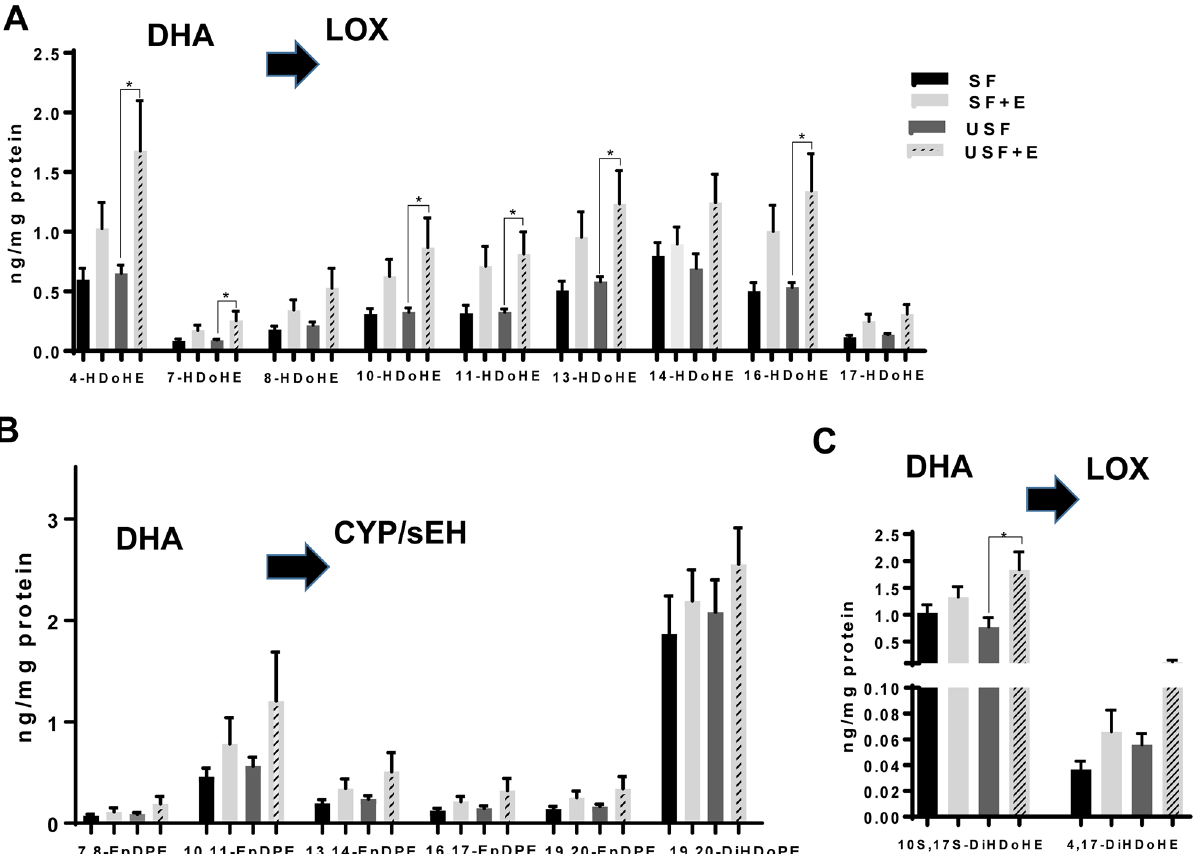
Fig 8. Changes in hepatic oxylipins derived from DHA. A: Levels of DHA-derived hydroxyl-metabolites of LOX pathway. D: Changes in epoxy- and dihydroxy-metabolites of DHA produced via CYP/sEH pathway. C: Pro-resolving DHA metabolites of LOX pathway. Data are presented as the mean ± SEM, Two way ANOVA, (cid:3) P < 0.05, n = 6 animals per group. CYP, cytochrome-P450 epoxygenase; DHA, docosahexaenoic acid; E, ethanol; LOX, lipoxygenase; SF, saturated fat; sEH, soluble epoxide hydrolase; USF, unsaturated fat. See oxylipin abbreviations in S6 Table.